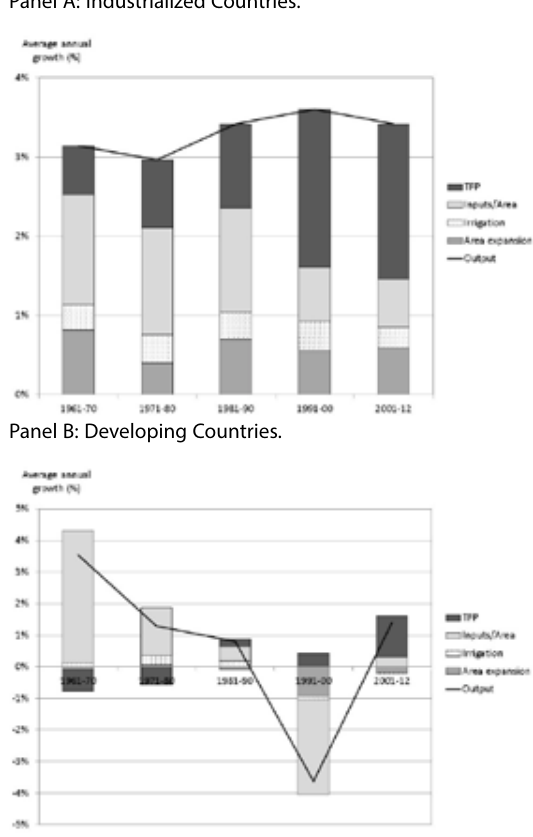
Panel C: Transition